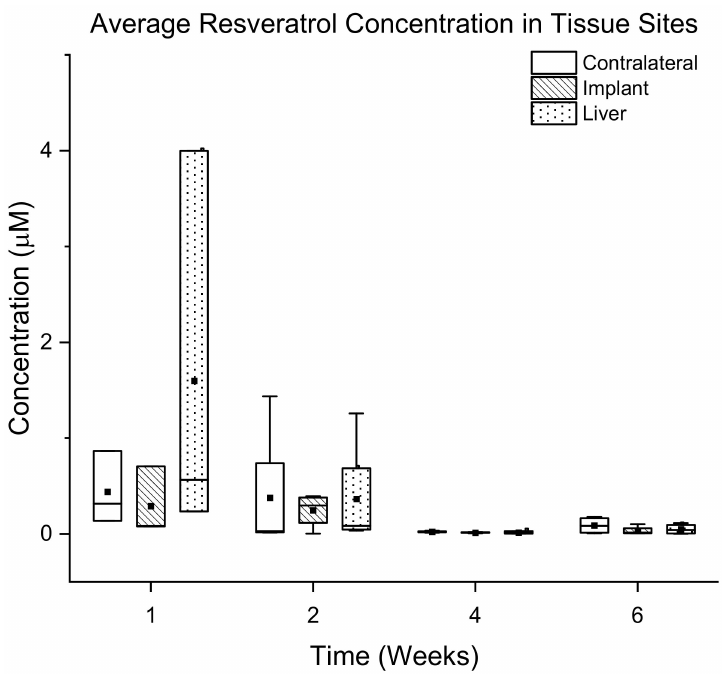
Figure 9. Quantification of Resveratrol in Tissue Over Time. Average concentration and standard error in µ M of resveratrol at the implant site, in brain tissue contralateral to the implant, and in the liver. There is no significant difference in resveratrol levels at all time points, but there is a general trend of higher levels at the acute time points (1 and 2 weeks), and a decrease at chronic time points (4 and 6